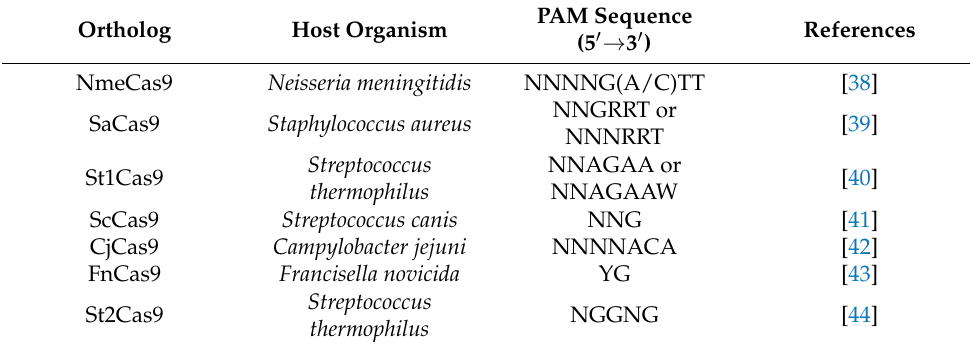
Table 1. Examples of Cas9 protein orthologs. Ortholog Host